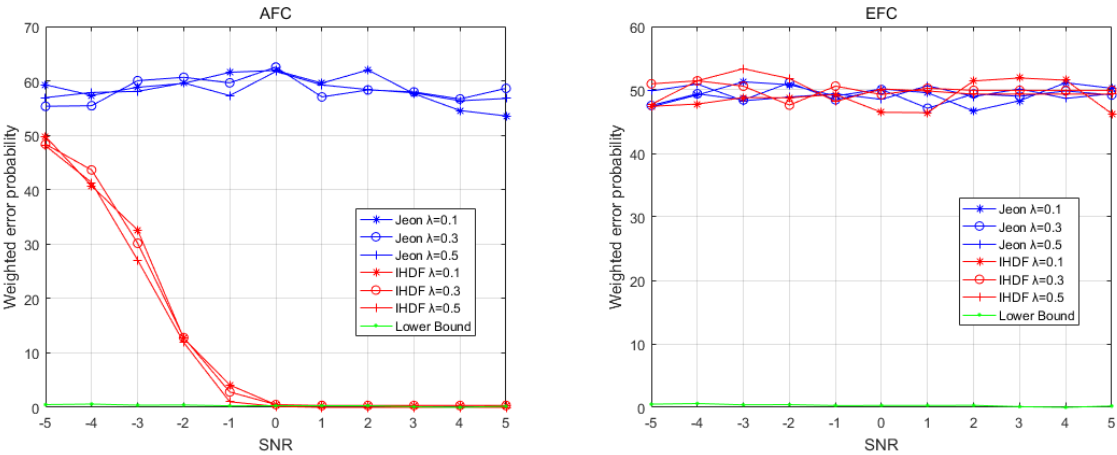
Figure 5. The weighted error probabilities at the AFC and EFC as a function of SNR in time-varying channel conditions.